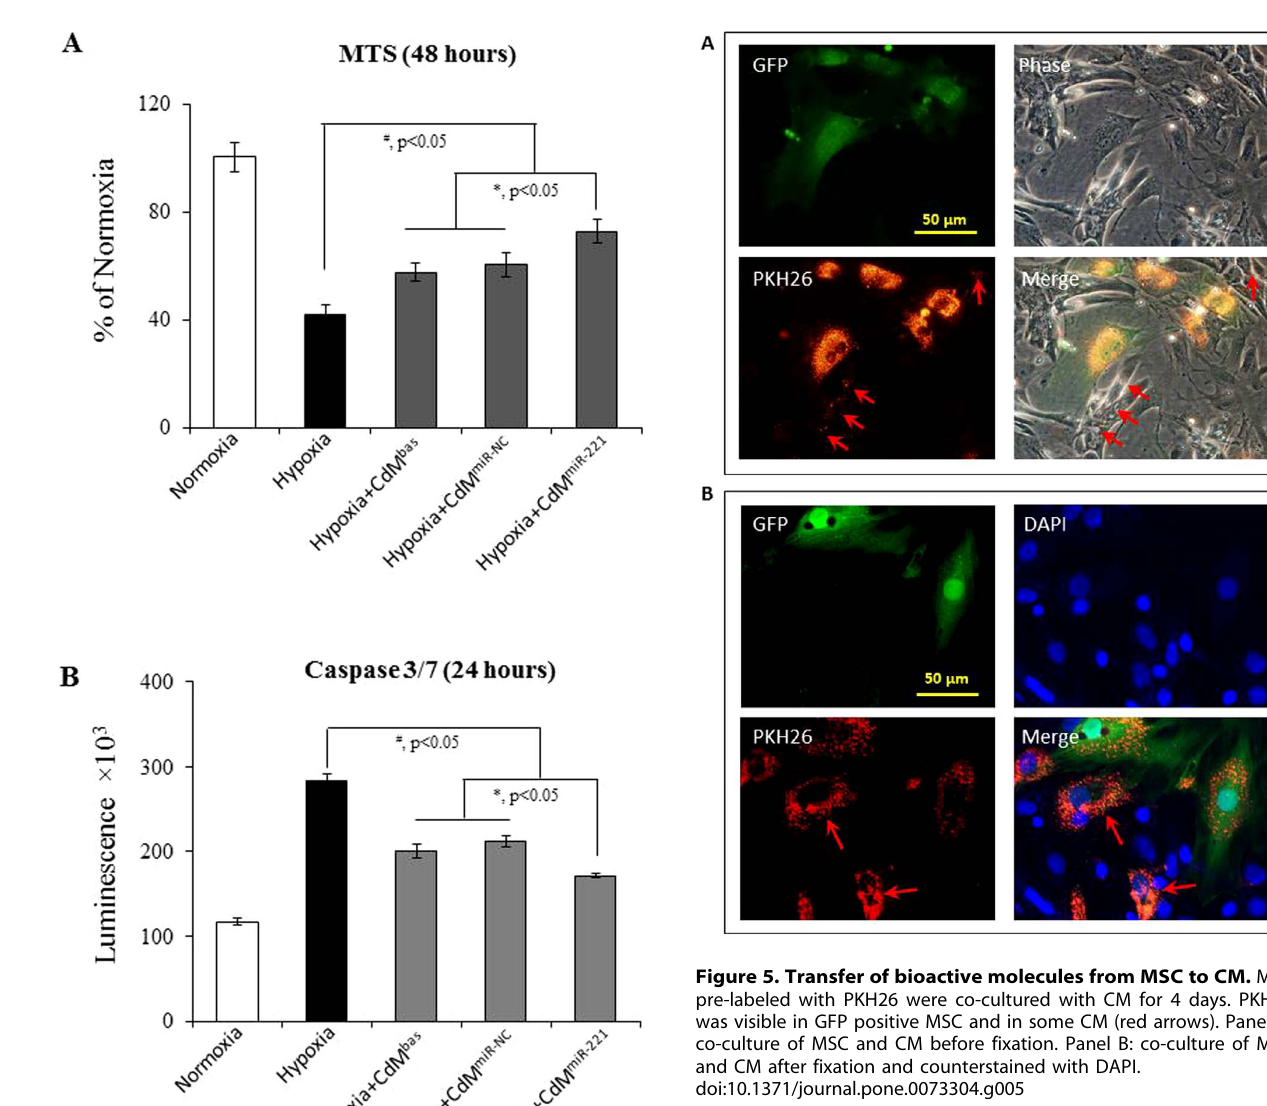
Figure 8A. No clear red MVs could be seen in CM during the first 2 hours. Very little but some red fluorescent spots appeared in CM by hour 3 (white arrows). PKH26-MVs were clearly visible in many CM by hour 8. To confirm whether MVs were transferred into CM, cultured cells were fixed and labeled with anti- a -actinin.